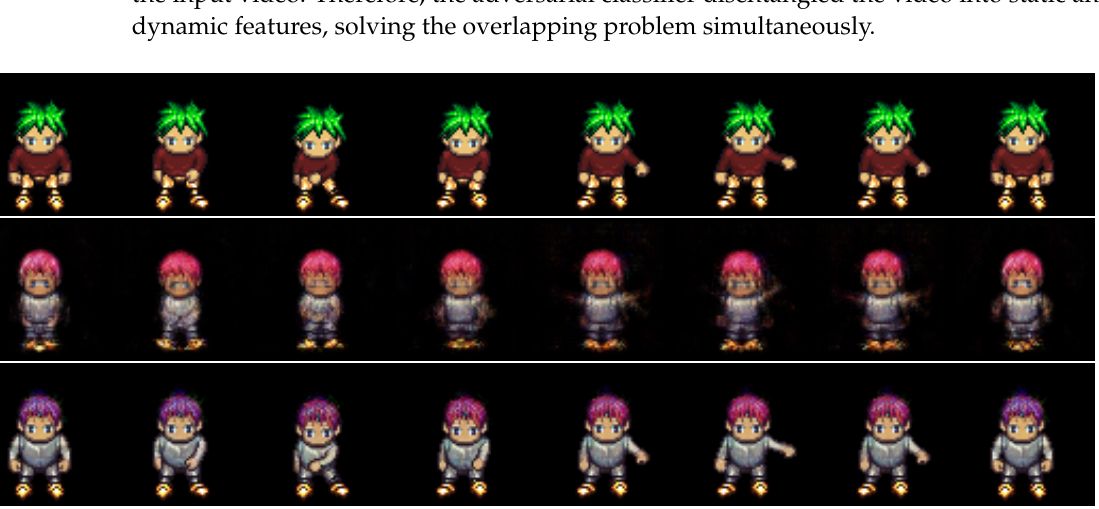
Figure 7. Example of zero-replaced generation on the Sprites dataset. We fixed the dynamic variables and replaced the static variable with zero. The top, middle, and bottom rows denote the input video and the results using DSVAE and the proposed method, respectively.